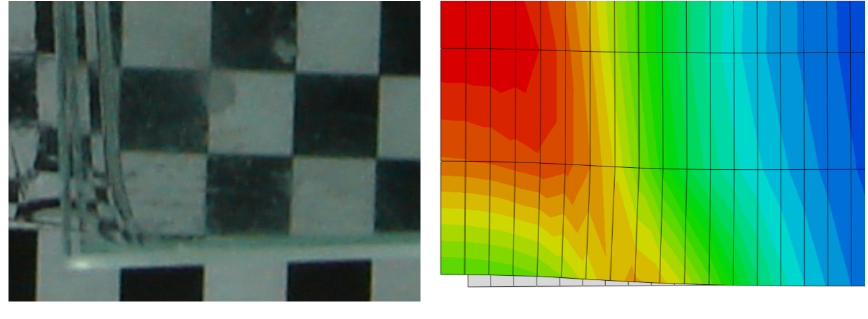
Figure 6: Left: typical delamination pattern at 45°C; Right: model with Finite Elements and cohesive